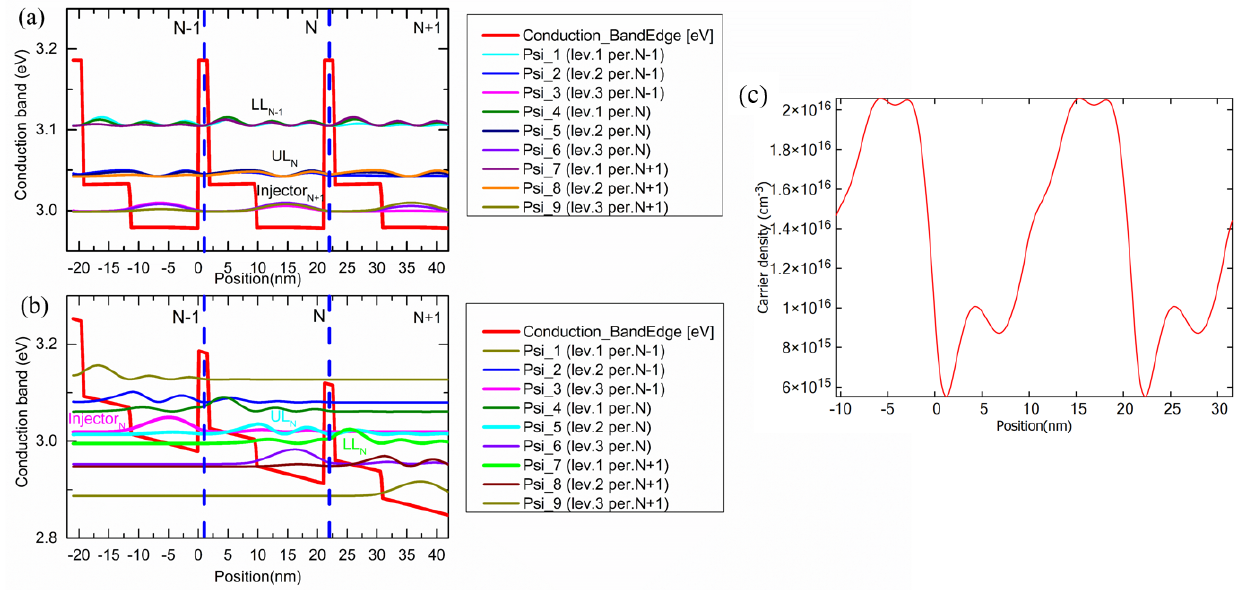
Figure 1. Conduction band diagram and carrier distribution at 100 K. ( a ) Concept conduction band diagram of a Q1W design (1.7 nm Al 0 . 25 Ga 0 . 75 As/8 nm Al 0 . 07 Ga 0 . 93 As/11.4 nm GaAs) at zero bias. ( b ) Conduction band diagram of a Q1W design at a design bias of 72 mV per period. ( c ) Carrier distribution along two periods from − 10.45 nm to 31.55 nm.